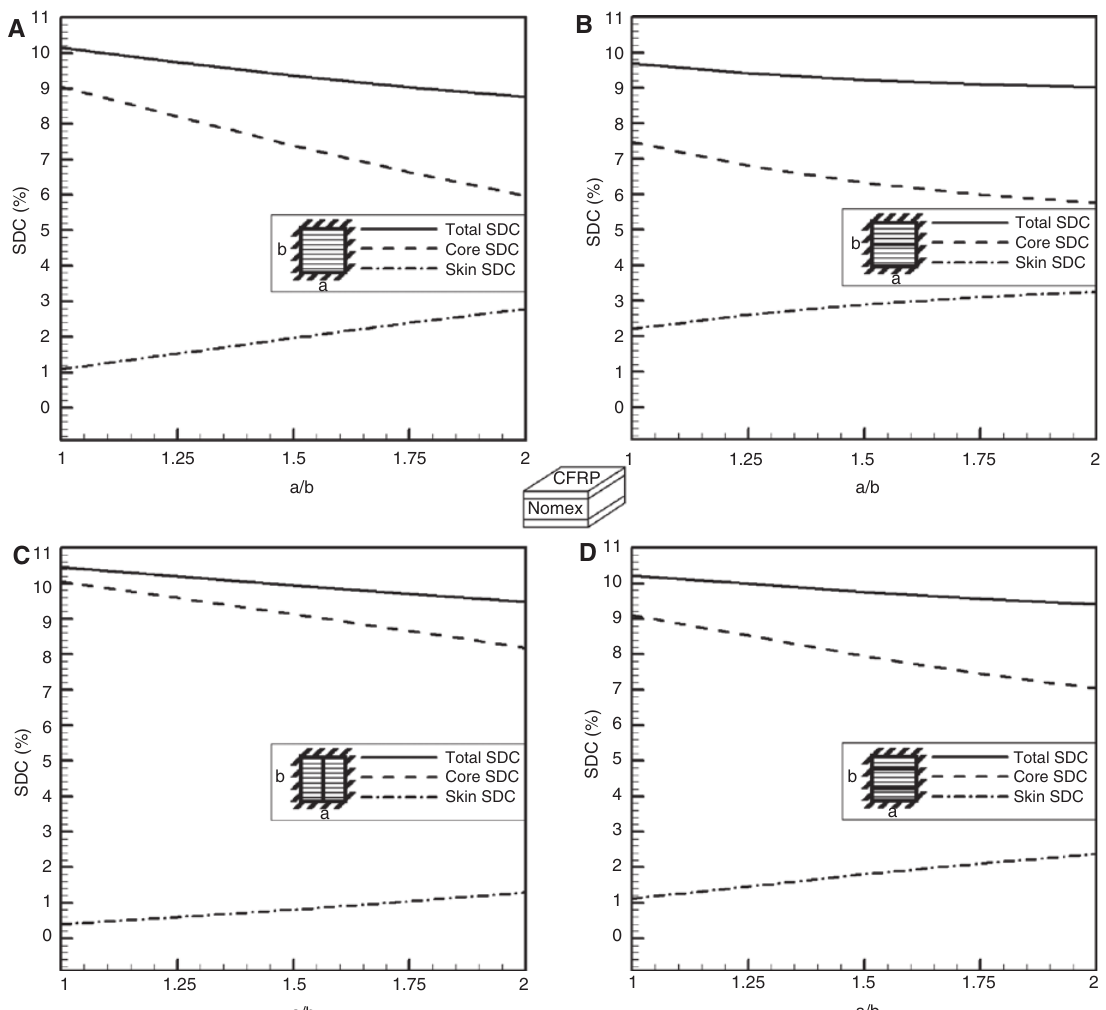
Figure 6: Damping of an all-clamped, all-zero CFRP/Nomex honeycomb sandwich panel versus aspect ratio, in various modes. (A) First mode, (B) second mode, (C) third mode, (D) fourth